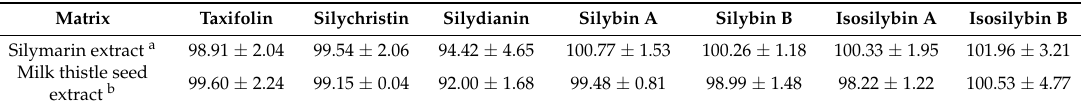
Table 4. Estimation of matrix effects by recovery results for individual analytes at spiked concentration of 50 ppm in two different